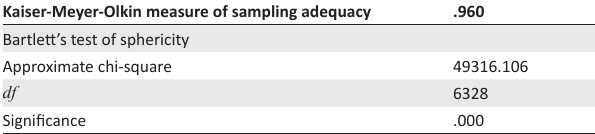
TABLE 1: Kaiser-Meyer-Olkin and Bartlett’s